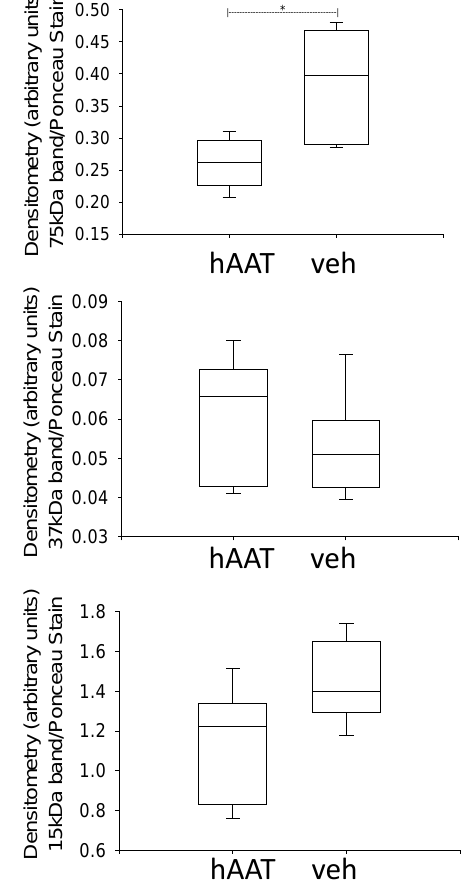
Figure 5. Western blot and densitometric analysis of MARCKS protein expression after hAAT or vehicle treatment. ( A ). Western blot for MARCKS protein expression. Eighty micrograms of total protein from kidney cortex lysates from hypertensive diabetic db/db mice treated with either hAAT or vehicle were resolved by SDS-PAGE and then transferred to nitrocellulose membranes which were blotted for MARCKS protein expression. ( B ). Image J was used to obtain densitometry values for each band which were normalized to the Ponceau staining. N = 6 mice in each group. * p <